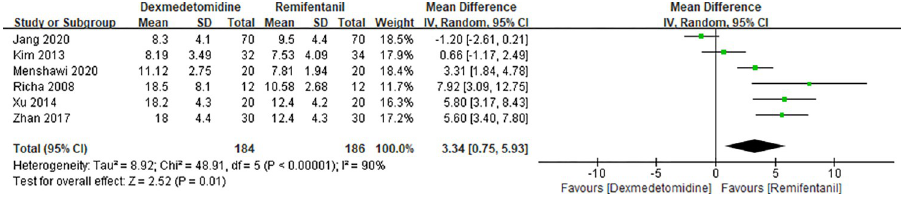
Fig 8. Forest plot of extubation time. Dexmedetomidine group vs. remifentanil